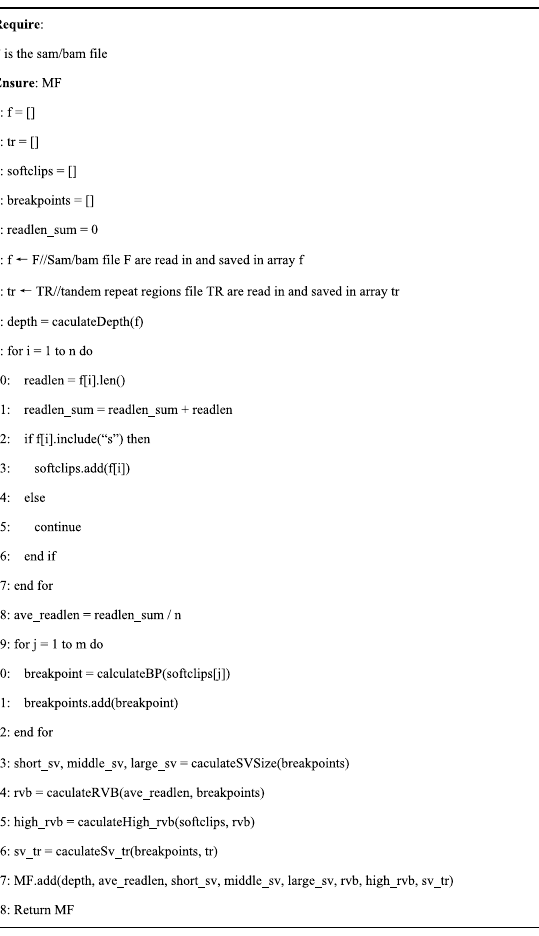
Algorithm 1. Meta-feature extraction